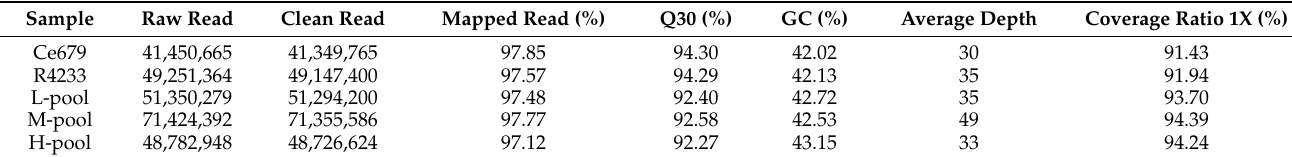
Table 3. Overview of the BSA-seq